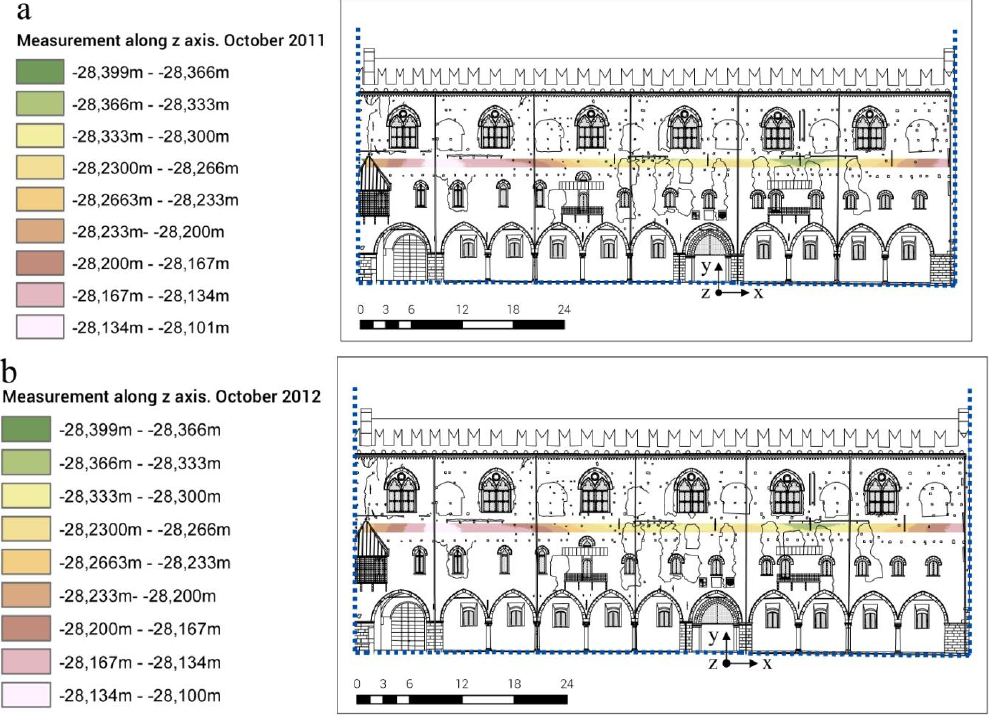
Figure 16. TLS data analysis in ArcGIS software: method of points interpolation based on the Inverse Distance Weighted (IDW) algorithm ( a ) October 2011. ( b ) October 2012.